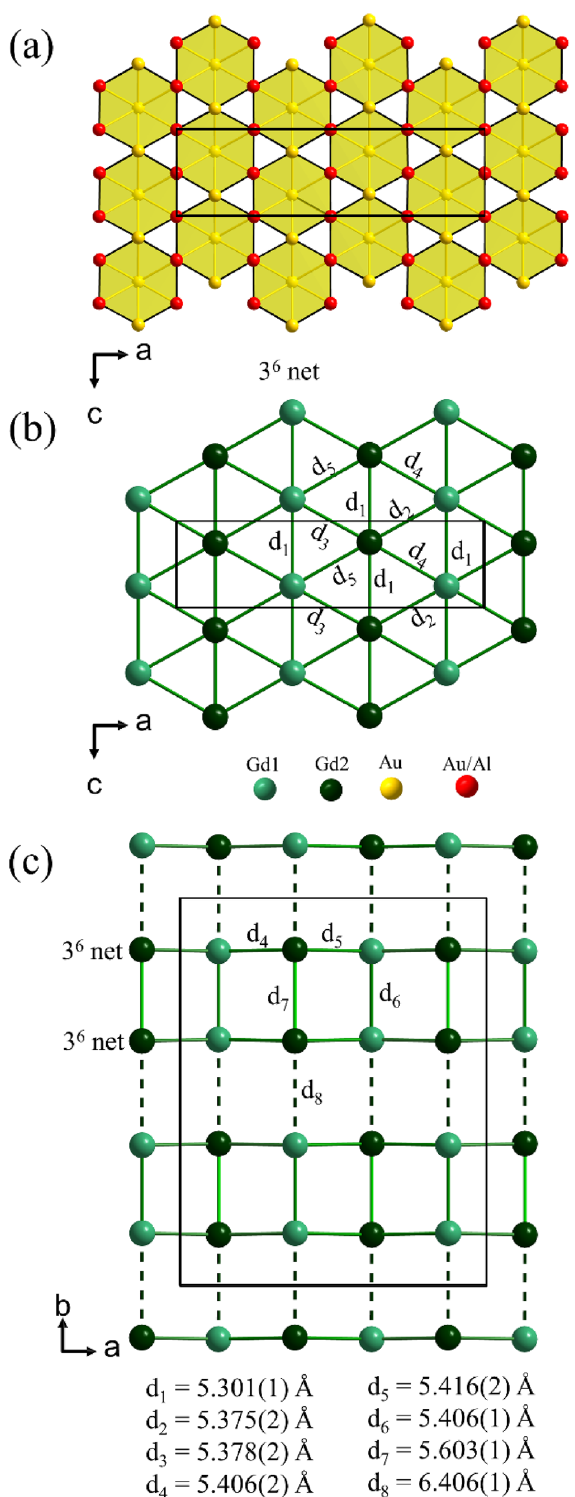
Figure 4. ( a ) Au8 coordination and Kagome nets formed by Au11, Au12 and (Au/Al)13–16 atoms. ( b ) Slightly corrugated 3 6 net formed by Gd atoms in the ac plane. ( c ) Stacking of Gd nets along the b direction. Nearest interatomic Gd–Gd distances are listed. The unit cell is shown by a rectangle in each plot; the plots are proportionally scaled to each